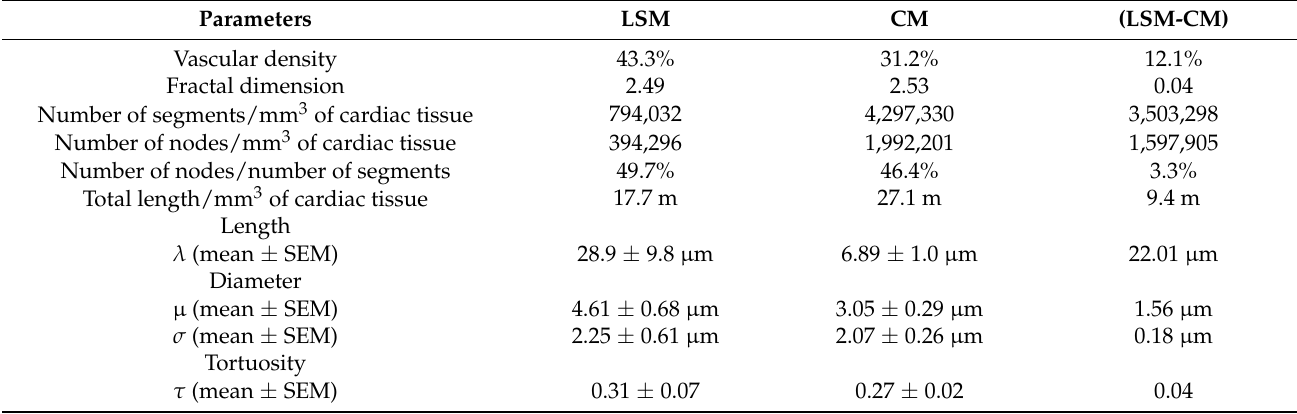
Table 5. Light sheet microscopy versus confocal microscopy. Global and architectural parameters obtained on light sheet microscopy (LSM, voxel size 0.5 × 0.5 × 2 µ m) and confocal microscopy (CM, voxel size 380 × 380 × 630 nm). The difference between LSM and CM (LSM-CM) values was